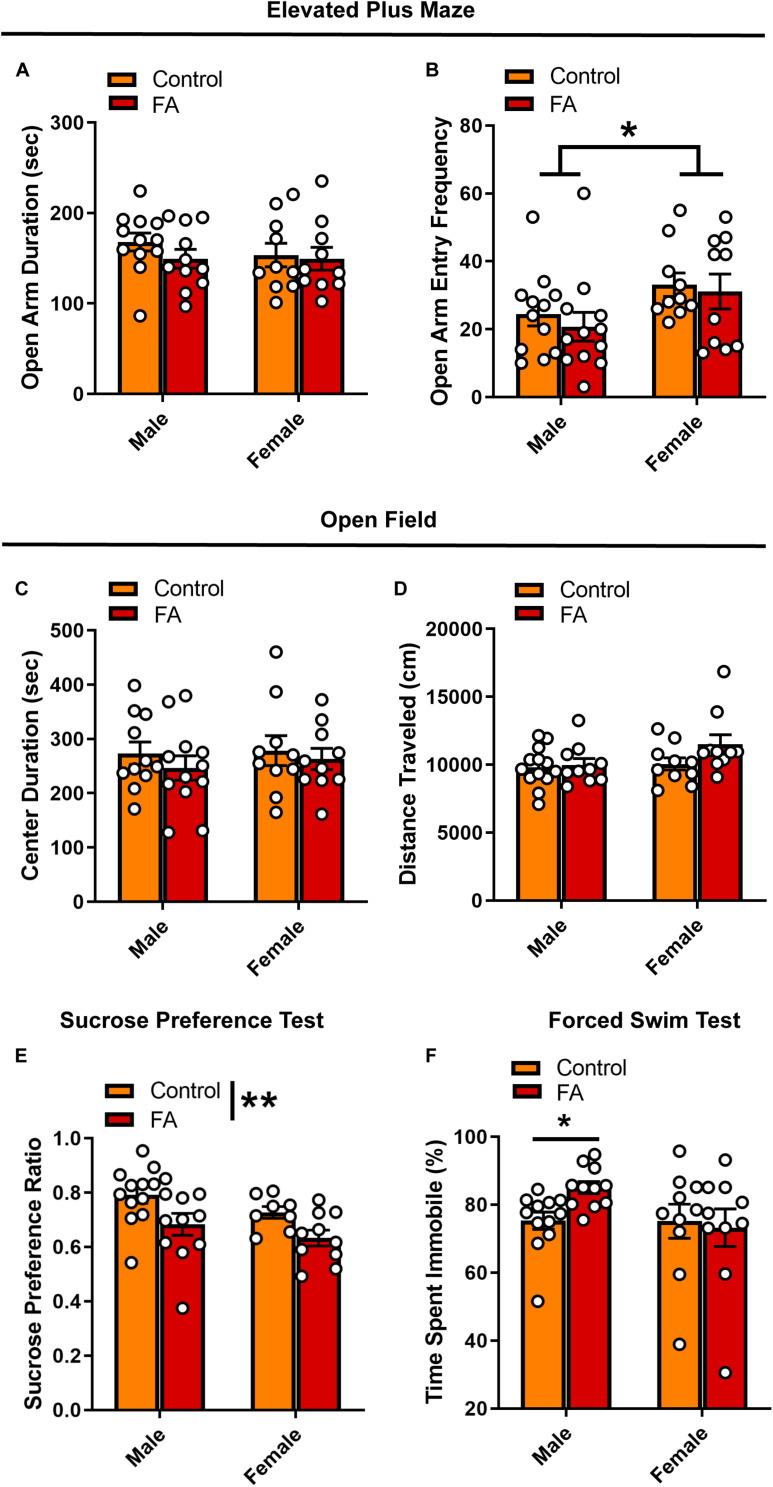
Forced abstinence from alcohol induces a depressive-like behavioral phenotype. (A) No significant difference in time spent in the open arm of the EPM was observed across sexes and FA conditions. (B) Female mice made more entries to the open arms than male mice, and this effect was not modulated by alcohol conditions. (C) No significant difference in time spent in the center zone of the OPT and (D) total distance traveled was observed across sexes and FA condition. (E) FA-exposed male and female mice displayed lower sucrose preference in the SPT than their control counterparts. (F) FA-exposed male mice spent more time immobile in the FST than control male mice. This effect was not observed in female mice. *p < 0.05, **p < 0.01.